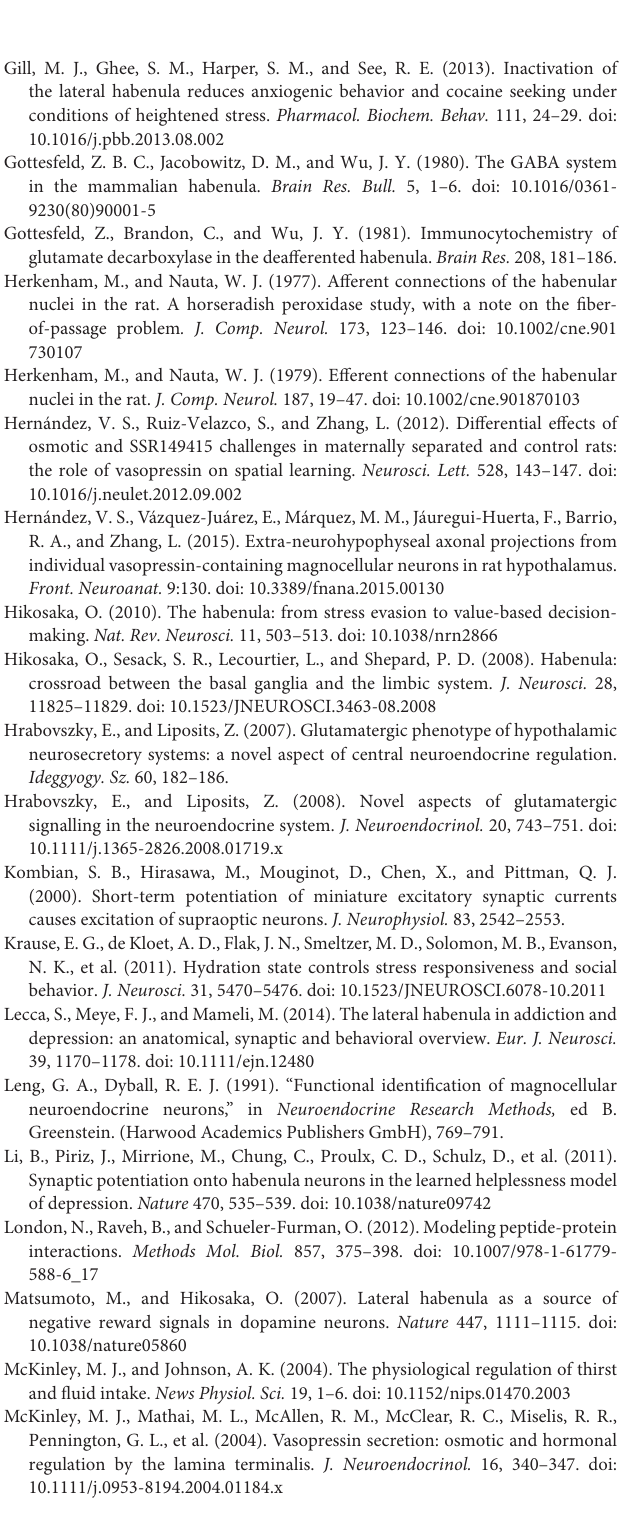
Table S1 | Antibody information, related to Material and